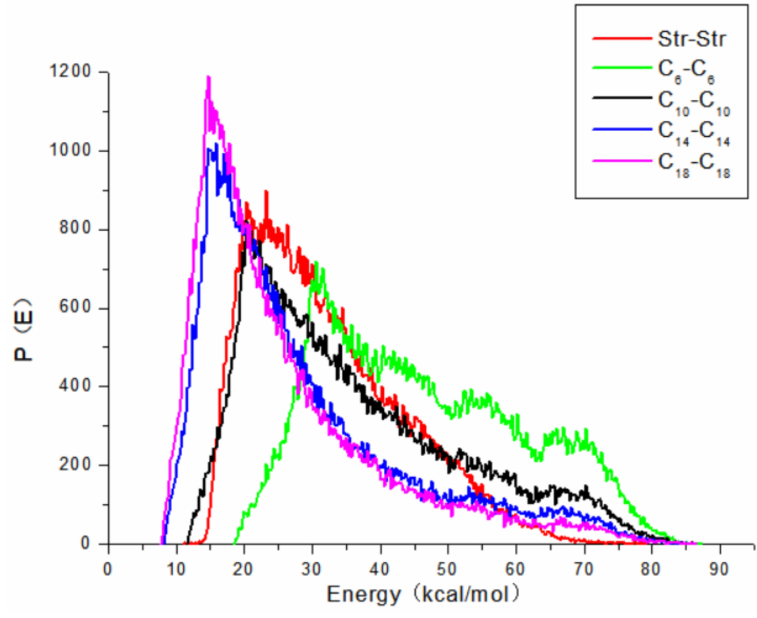
Figure 6. The binding energy distribution curves of Str and different fatty acids.